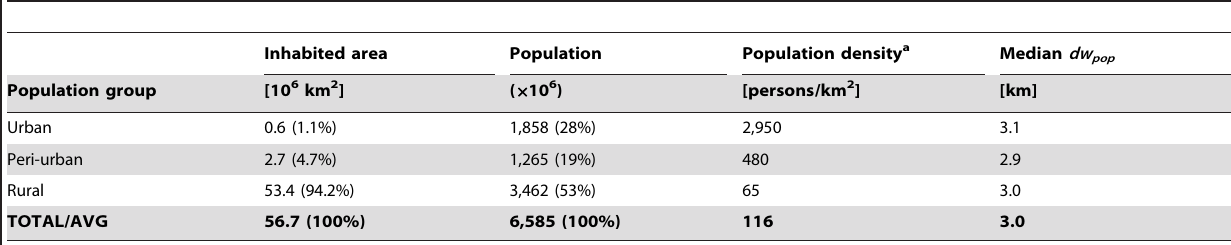
Table 2. Population groups with the inhabited area, population, average population density, and population distance to water ( dw pop ).